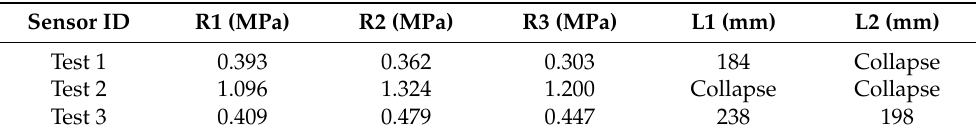
Figure 2. Test setups. Table 1. Main test